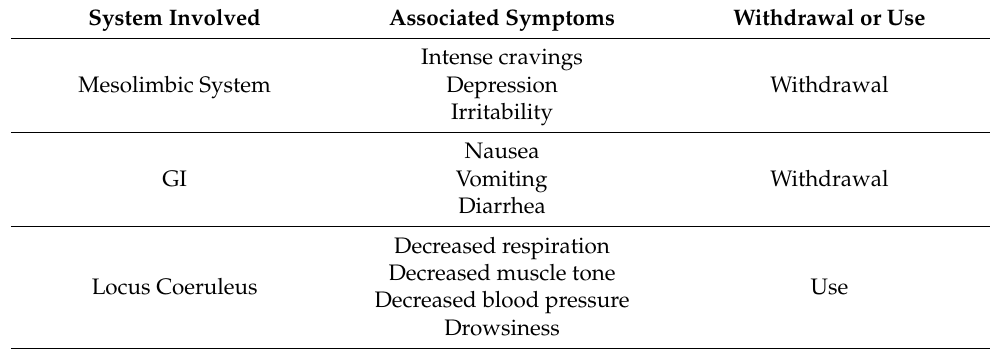
Table 1. Body systems involved in the associated symptoms of either opioid use or